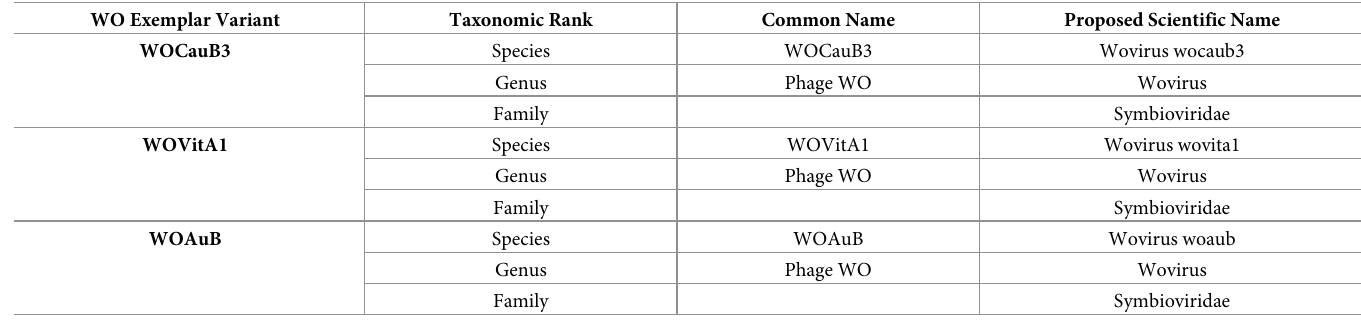
Table 1. The correlation between common name and proposed scientific name is listed for each phage WO exemplar variant and taxonomic rank. WO Exemplar